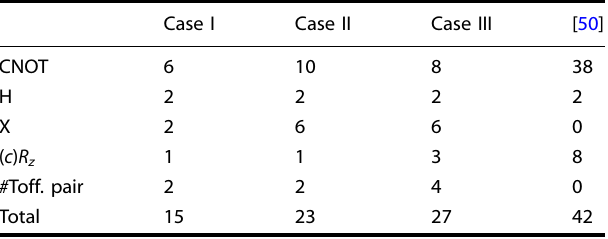
Table 1. Comparison of gate counts required to simulate e − iHt (Eqs. (19), (20)) using the circuit synthesized by us with the circuit in ref. 50 .